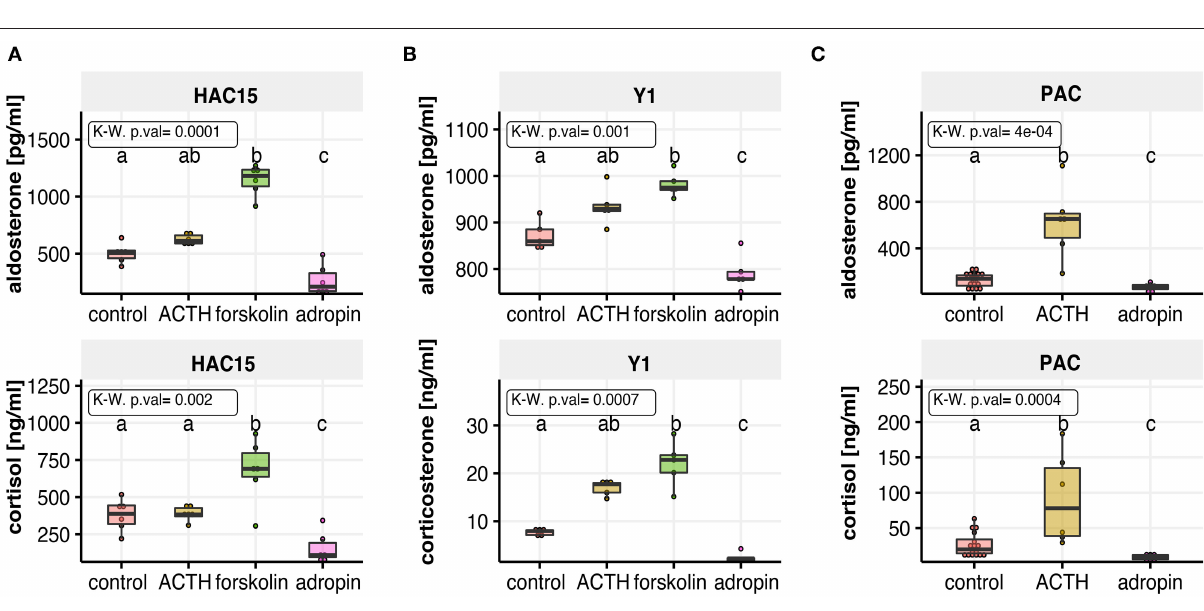
FIGURE 2 | The effect of adropin on aldosterone and cortisol or corticosterone secretion in the following cell culture models: human adrenal carcinoma (HAC15) cell line (A) , mouse adrenocortical tumor (Y1) cell line (B) and primary human adrenal carcinoma (PAC) cell culture (C) . All of studied cells were exposed to adropin for 24h. ACTH or forskolin treated cells were used as a positive controls. Results are presented as medians with IQR. Statistical differences were determined by Kruskal–Wallis test followed by Dunn’s post hoc test. Groups sharing the same letter are not significantly different according to Dunn’s